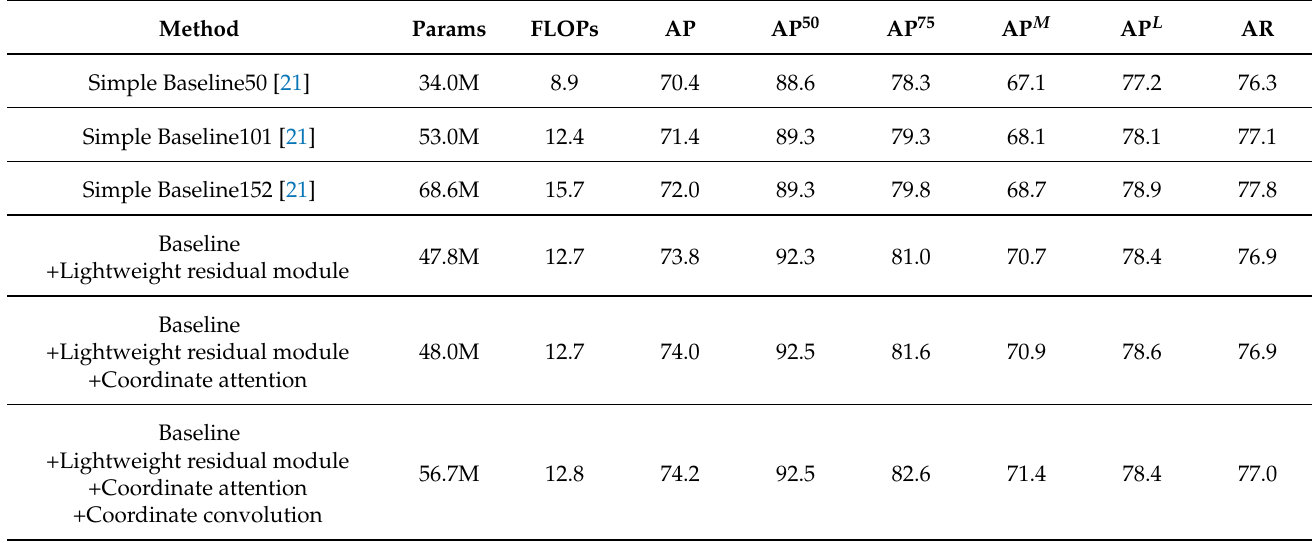
Table 2. Ablation experiment of the models on the COCO validation